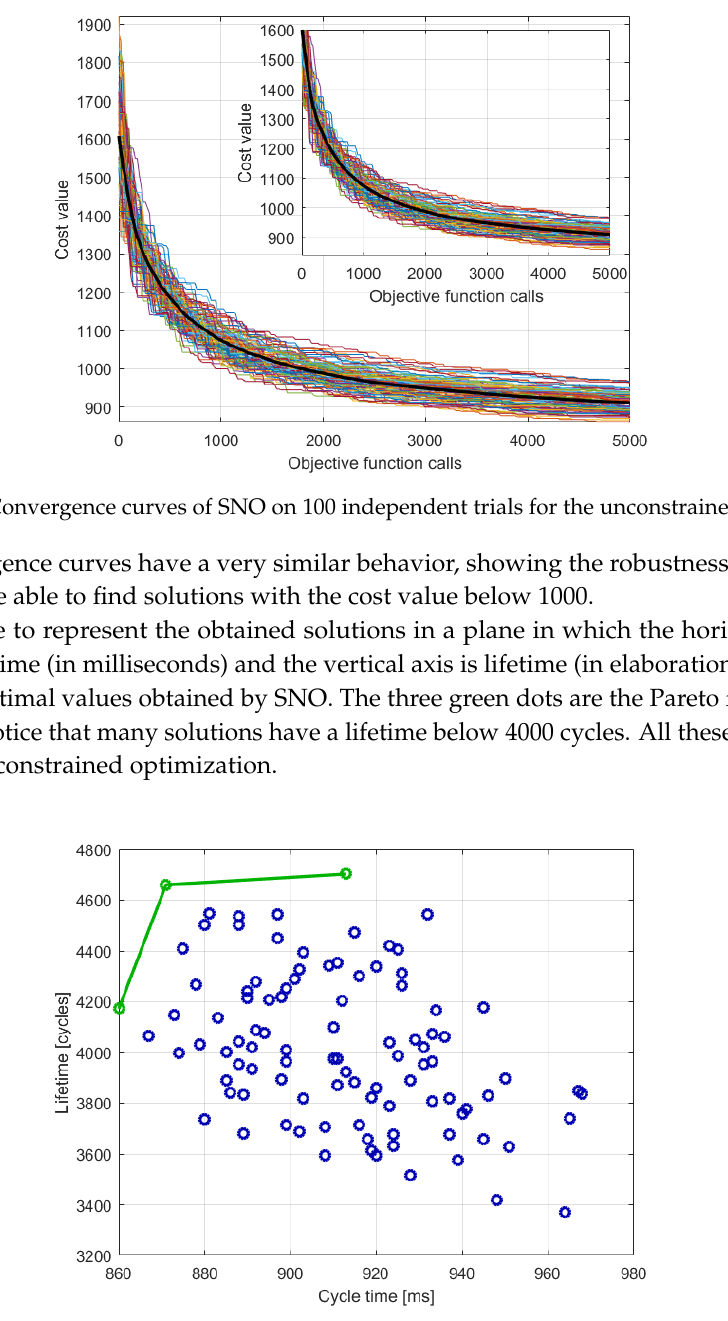
Figure 6. Optimal solutions found by SNO in the cycle time–lifetime plane. The green represents the Pareto